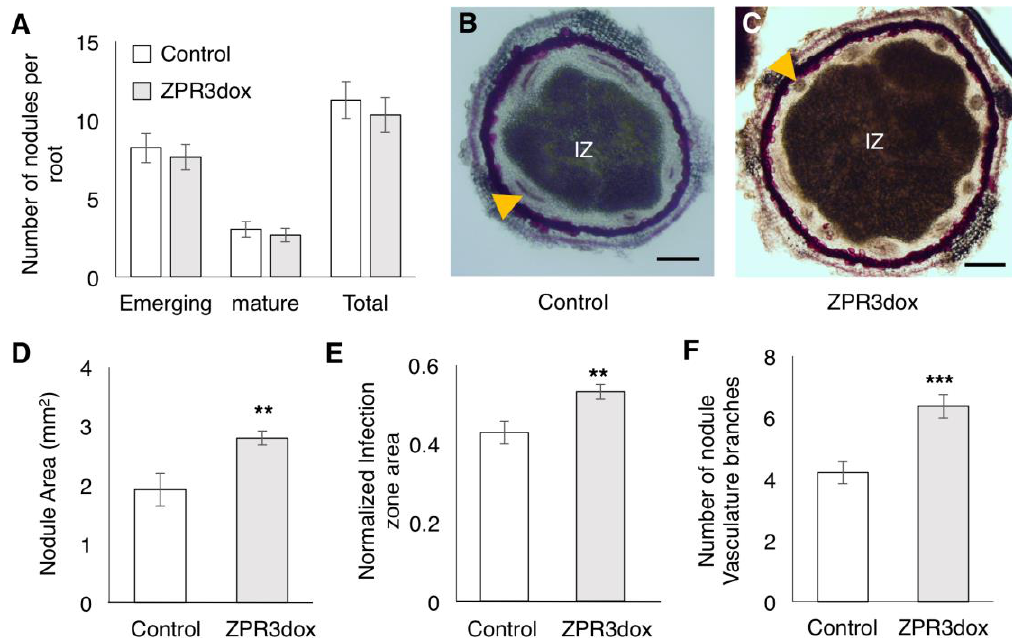
Figure 7. ZPR3d overexpression alters nodule size and vasculature. ( A ) Number of emerging, mature, and total nodules on Vector control and ZPR3dox roots. No significant difference observed based on Poisson distribution analysis. Data shown are average from at least 140 independent transgenic roots for each construct. Error bars indicate SE. ( B , C ) Cross sections of representative nodules from ( B ) vector control and ( C ) ZPR3dox roots sectioned transversally to the nodule axis and stained with phloroglucinol. A nodule vascular bundle is indicated by the yellow arrowhead; IZ – Infection Zone (central zone). Scale bars are 200 µ M. ( D , E ) Nodule area and infection zone area normalized as a proportion of nodule area in nodules from vector control and ZPR3dox roots. Data shown are averages ( n = 10 sections per construct each from an independent nodule) and error bars indicate SE. ** P < 0.01, Mann-Whitney-Wilcox test. ( F ) Number of nodule vascular bundles that has branched and is visible in median transversal sections of nodules from vector control and ZPR3dox roots. Data shown are averages ( n = 10 sections per construct each from an independent nodule) and error bars indicate SE. *** P < 0.001 Student’s t -test.